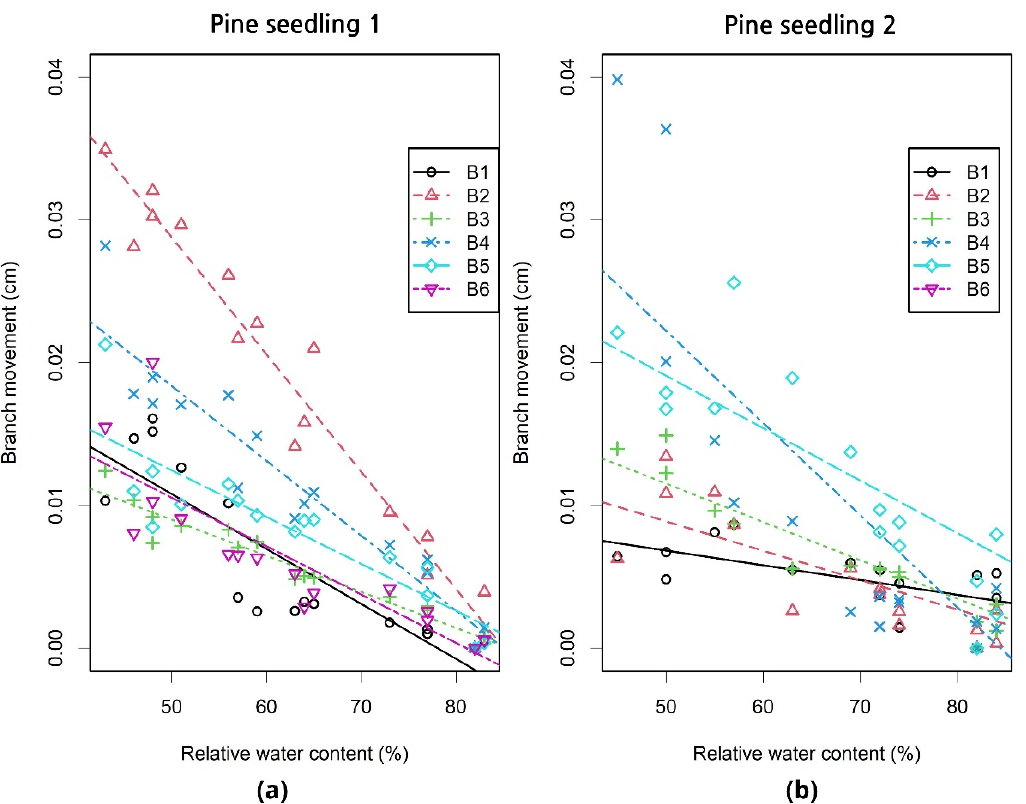
Figure 3. Relationship between relative water content (%) and branch movement (cm) for each branch in ( a ) Pine seedling 1 and ( b ) Pine seedling 2. Each line represents a regression line between branch movement and relative water content. The different symbols denote different branches.